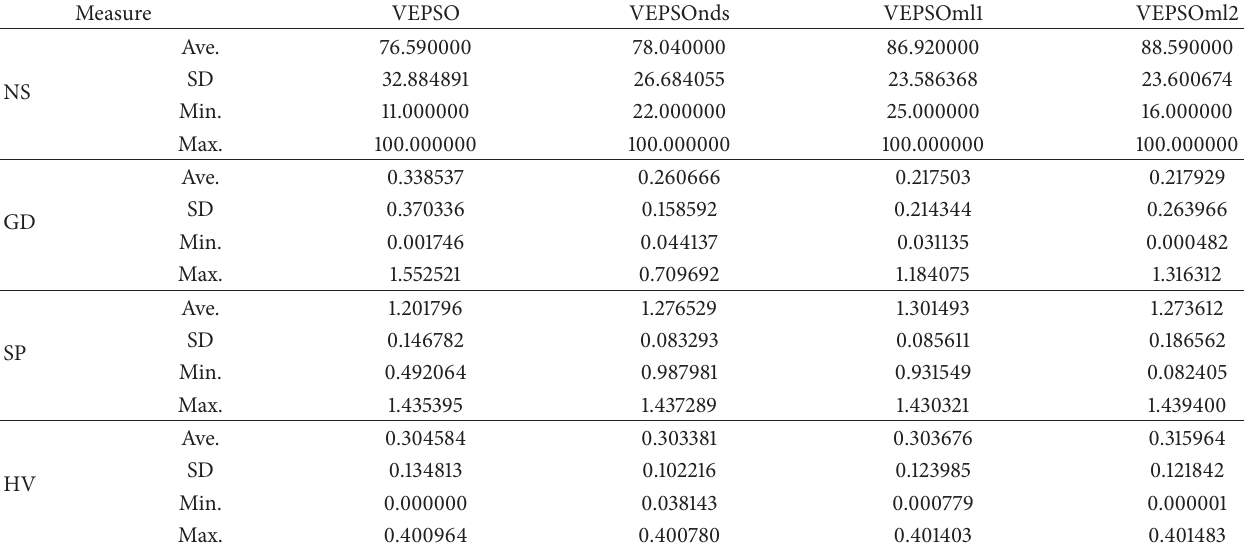
Table 6: Algorithm performance tested on ZDT6